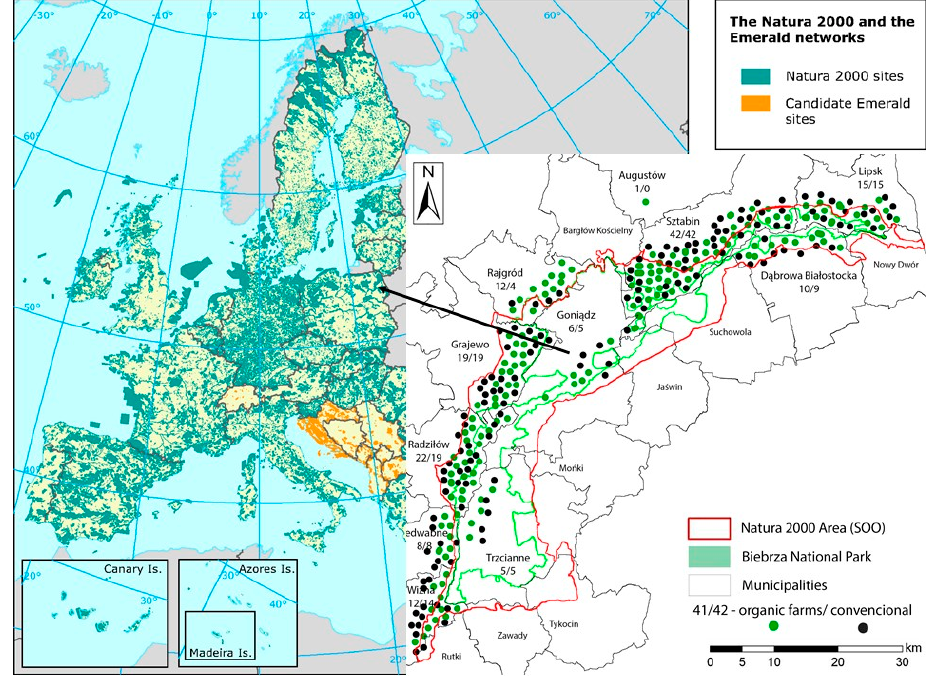
Figure 1. The area of N2K “Biebrza Valley” PLH200008 and the location of farms addressed by the study. Source: background map https://www.eea.europa.eu/data-and-maps/figures/the-natura-2000 accessed on 13 March 2021 and own research.